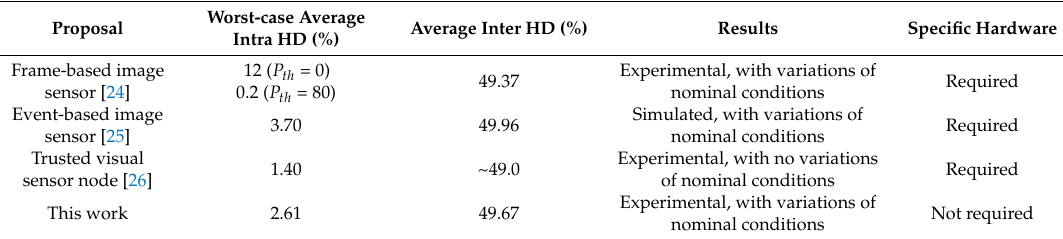
Table 1. Comparison with other proposals using hardware-based